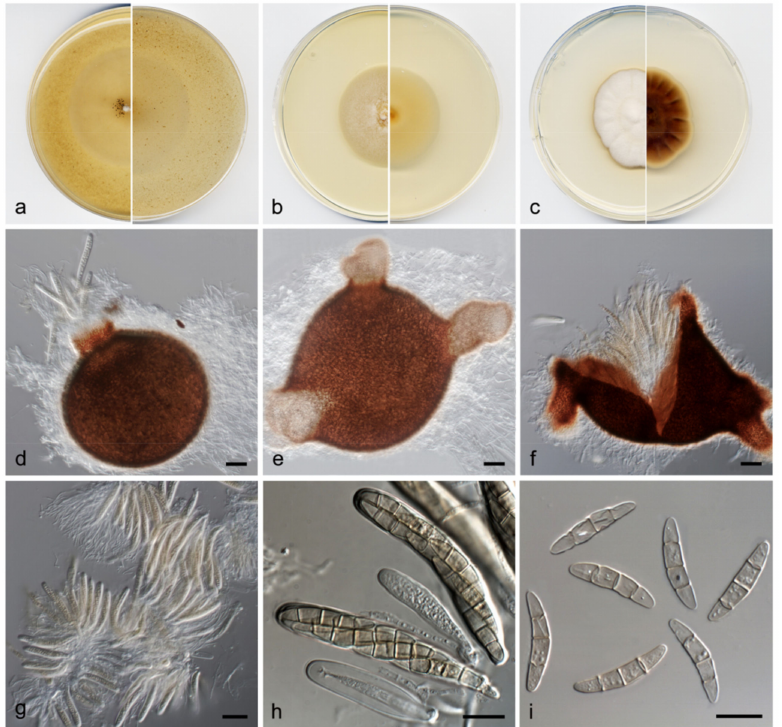
Figure 7. Phaeosphaeria fructigena FMR 17808: ( a ) colonies on OA; ( b ) MEA; and ( c ) PDA after two weeks at 25 ± 1 ◦ C (surface, left; reverse, right); ( d – f ) ascomata (( d ) expelling asci); ( g , h ) asci; ( i ) ascospores. Scale bars: ( d – f ) = 50 µ m, ( g – i ) = 10 µ m. Etymology . From Latin fructi -, fruits, and - genes , because of the production of ascomata in